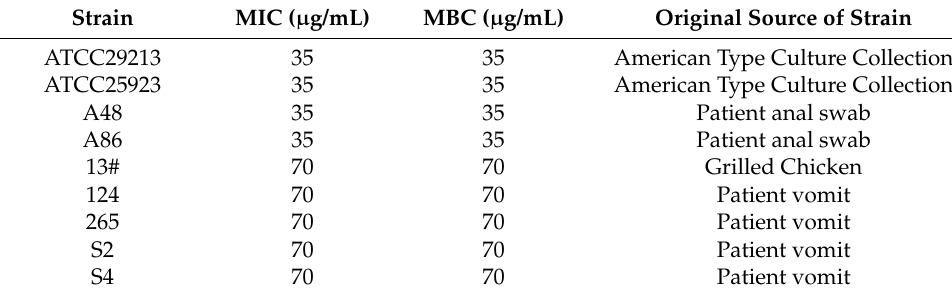
Table 2. MIC and MBC of Shikonin on 9 Strains of Staphylococcus aureus .